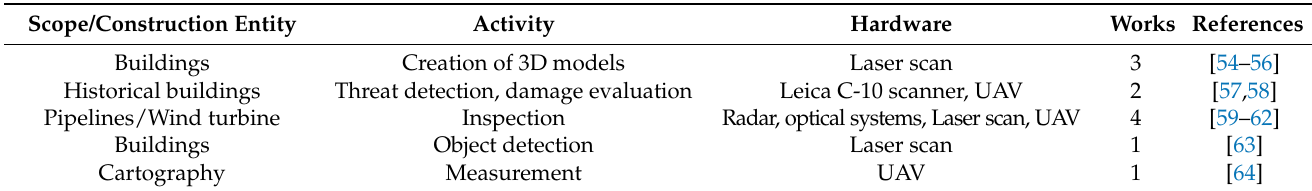
Table 1. Overview of the scope, topics, hardware used, and quantification of research works on “LiDAR” and “Renovation”.